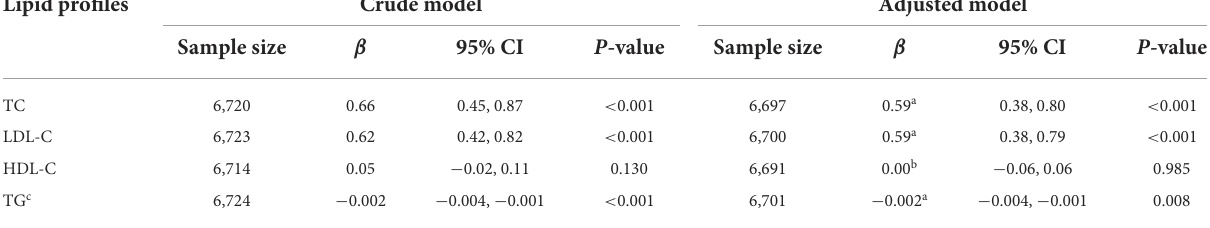
TABLE 4 Linear regression analyses for the association between DDS and lipid profiles among older participants. Lipid